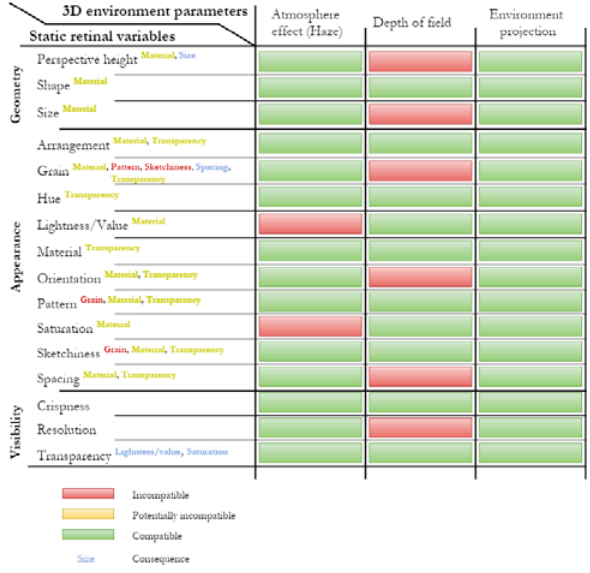
Figure 5 A decision table of selectivity for an urban visualisation at high density (part 1)